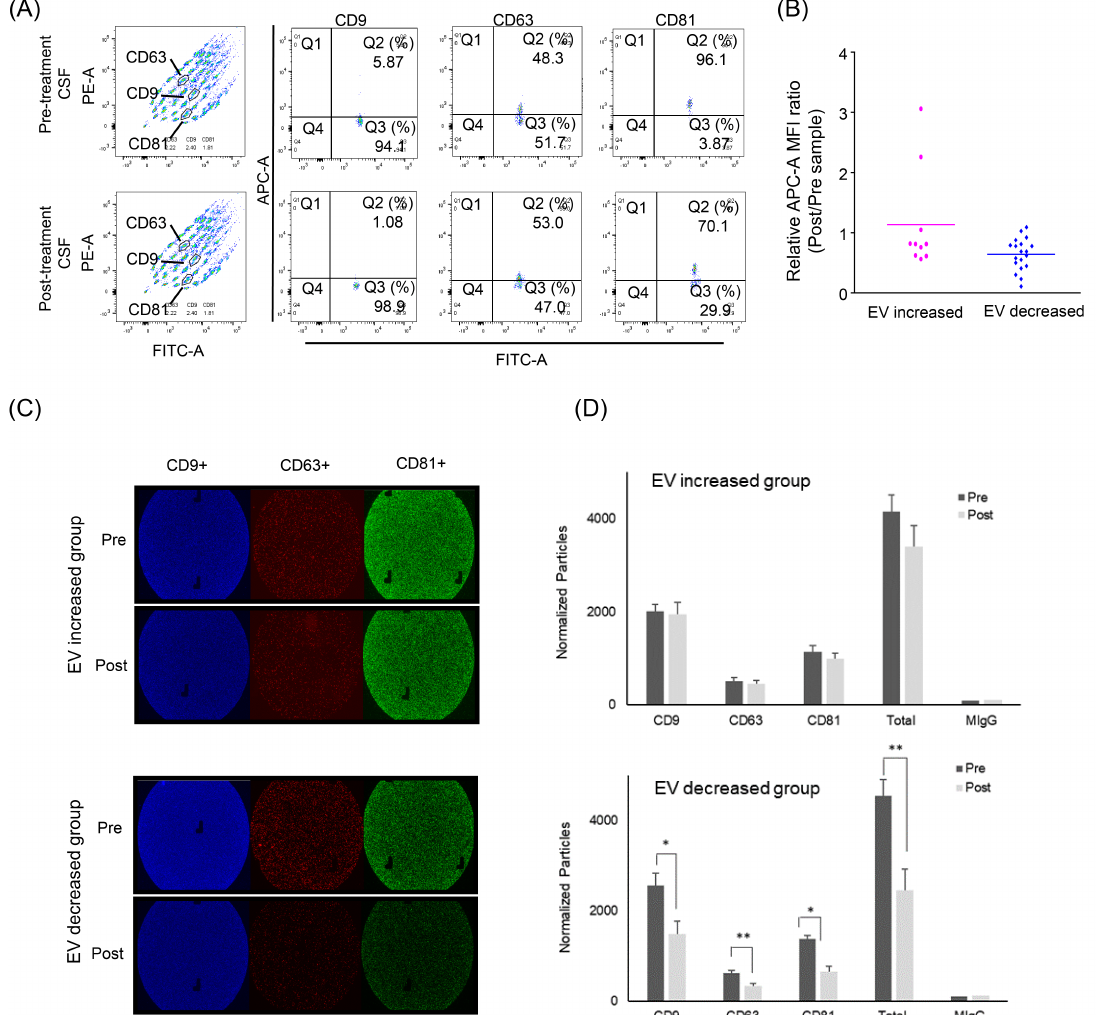
Figure 4. Evaluation of exosome concentration change after intraventricular chemotherapy by surface markers. ( A ) Flow cytometry using the MACSPlex Exosome Kit. ( B ) The relative expression of EV markers was determined by the mean fluorescence intensity (MFI) of APC-conjugated capture antibody. In the EV-decreased group, the exosome markers were significantly reduced after intraventricular chemotherapy (ratio 0.64, p < 0.001), whereas increased groups showed no significant exosome concentration change (ratio 1.13). ( C ) ExoView Tetraspanin Chip revealing exosome surface markers (CD9 in red, CD63 in green and CD81 in blue). ( D ) The change of each exosome marker after the intraventricular chemotherapy showed a significant decrease of all exosome markers in the EV-decreased groups ( p * < 0.05, p ** < 0.005). Tx: